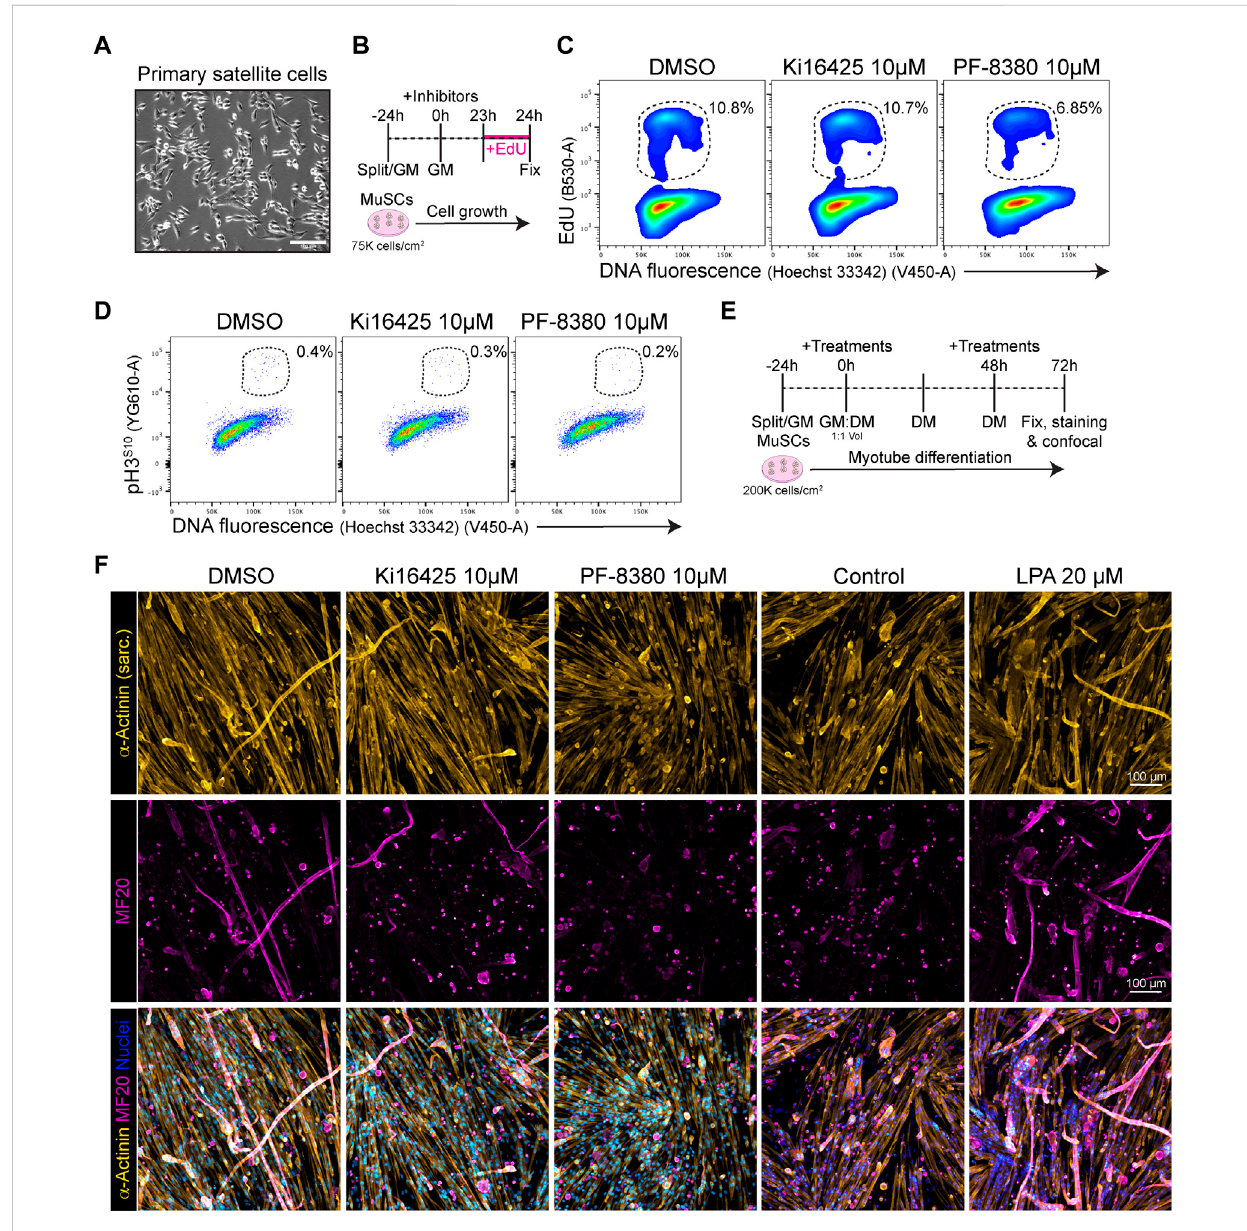
FIGURE 7 PF-8380 pharmacological inhibition of ENPP2 impairs satellite cell proliferation and myotube differentiation. (A) Bright fi eld images of cultured muscle stem cells (i.e., satellite cells). (B) Outline of EdU assay in muscle satellite cells. (C) Flow cytometry detection of EdU labelled cells in combination with DNA fl uorescence at 24 h of treatments. (D) Flow cytometry detection of mitotic (phospho-H3 S10 ) labelled cells in combination with DNA fl uorescence at 24 h of treatments. (E) Outline of satellite cell differentiation protocol. GM, growth media; DM, differentiation media. (F) Representative laser confocal images of day 3 myotubes after the different treatments. α -Actinin staining is shown in hot yellow, nuclear staining in hot blue, and MF20 in magenta. Scale bar: 100 μ